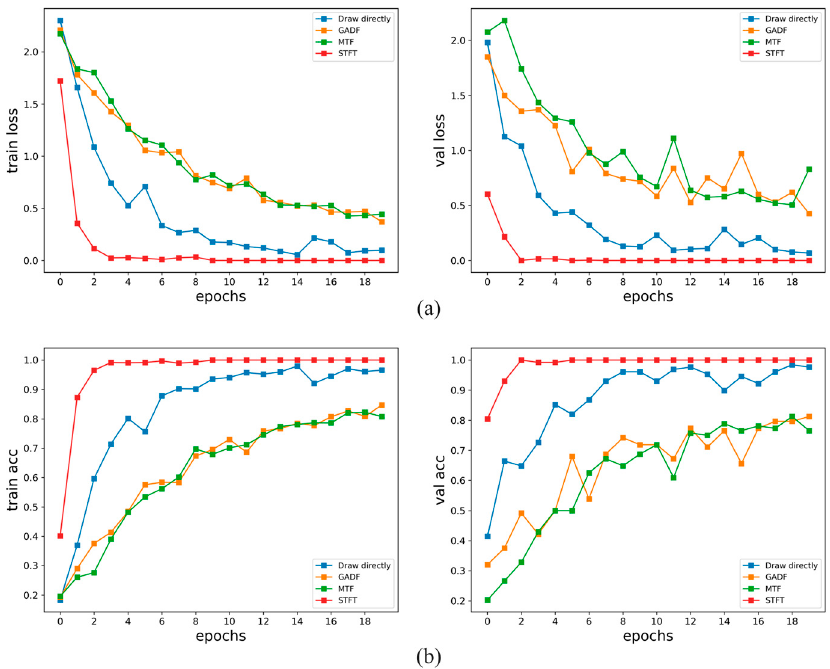
Figure 14. Training results of dual-channel data in the CWRU dataset: ( a ) Train loss and val loss, ( b ) Train acc and val acc.